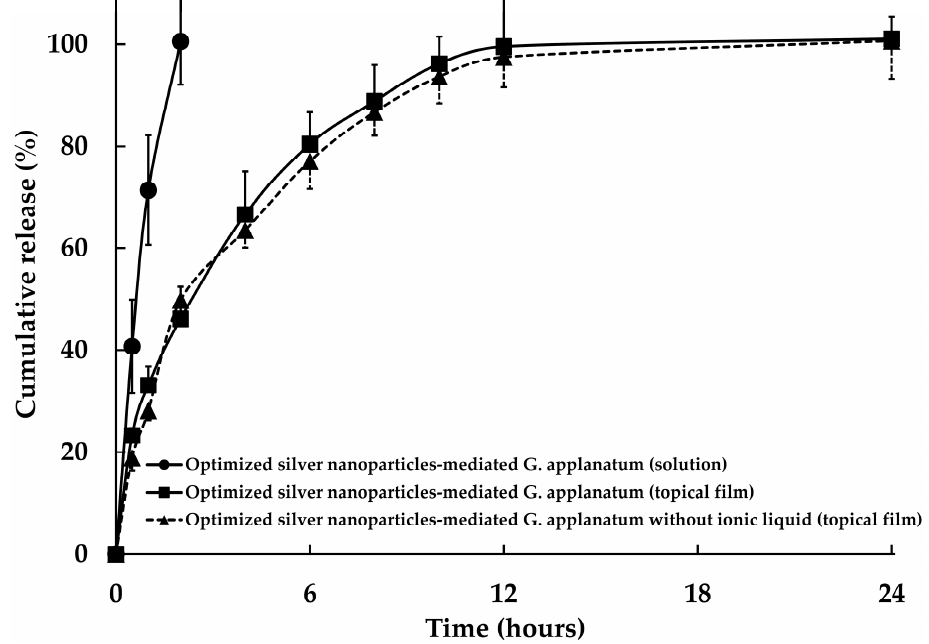
Figure 14. Release profile of silver-nanoparticle-complexed G. applanatum from the topical film.